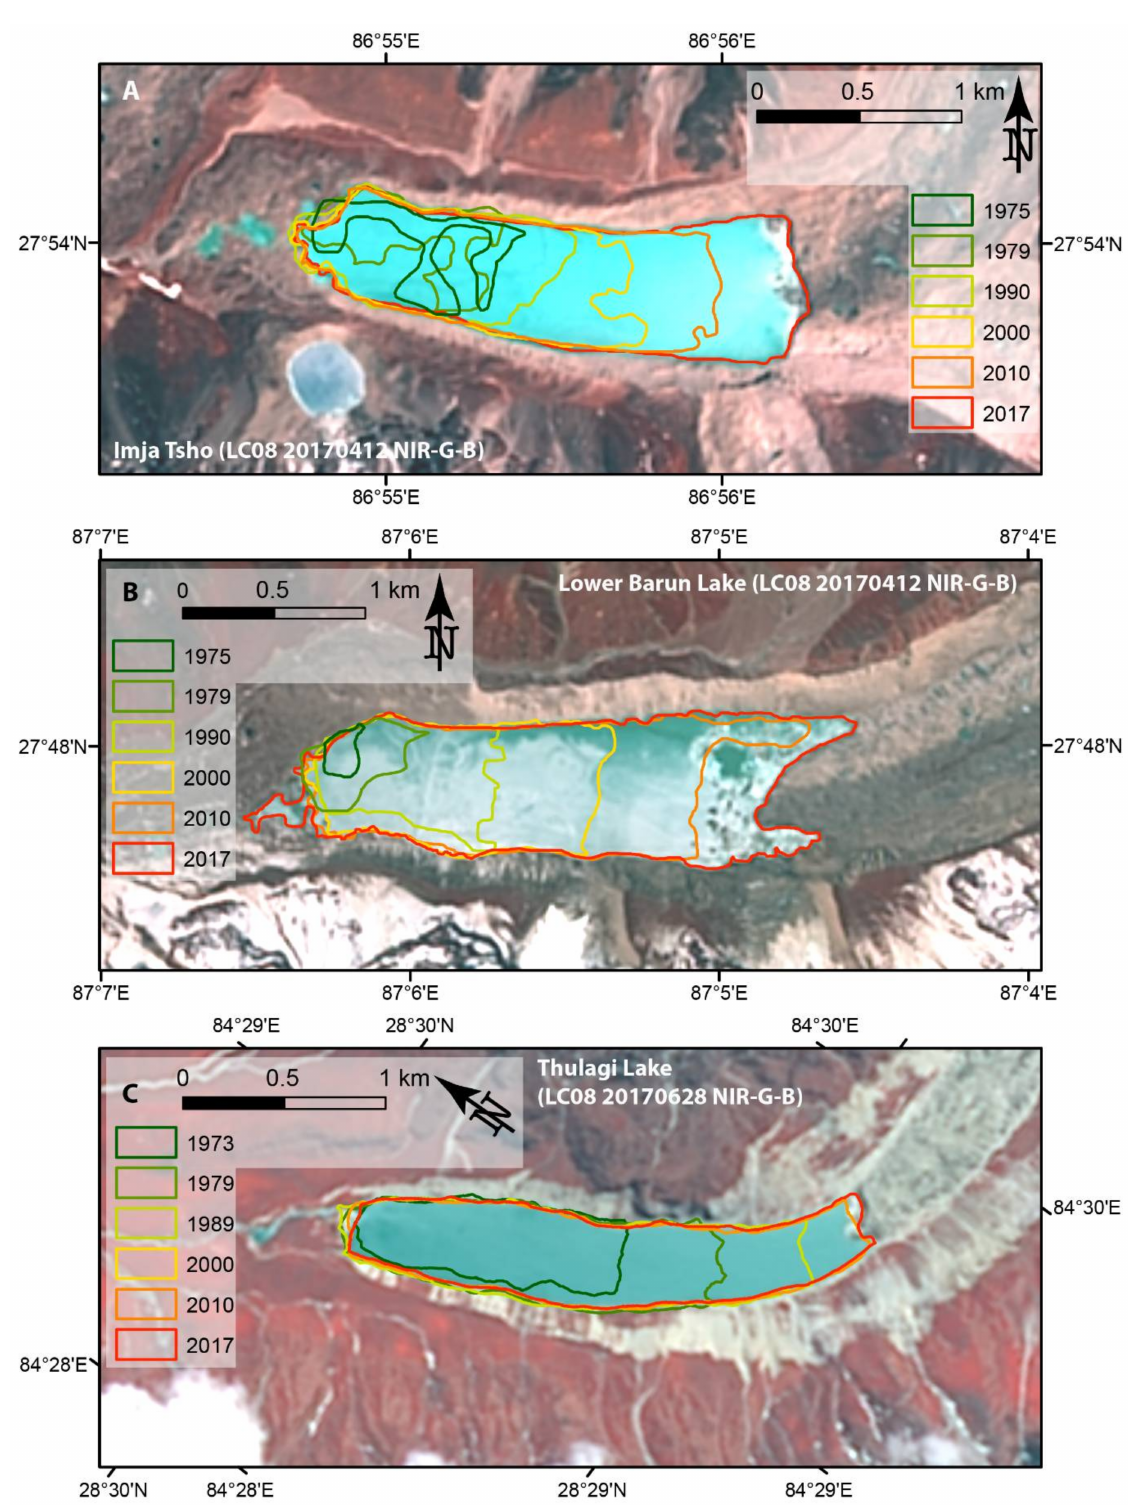
Figure 4. Long-term evolution of lake perimeter with ~4–11-year intervals for ( A ) Imja Lake, ( B ) Lower Barun Lake, and ( C ) Thulagi Lake. See Table S1 for full list of